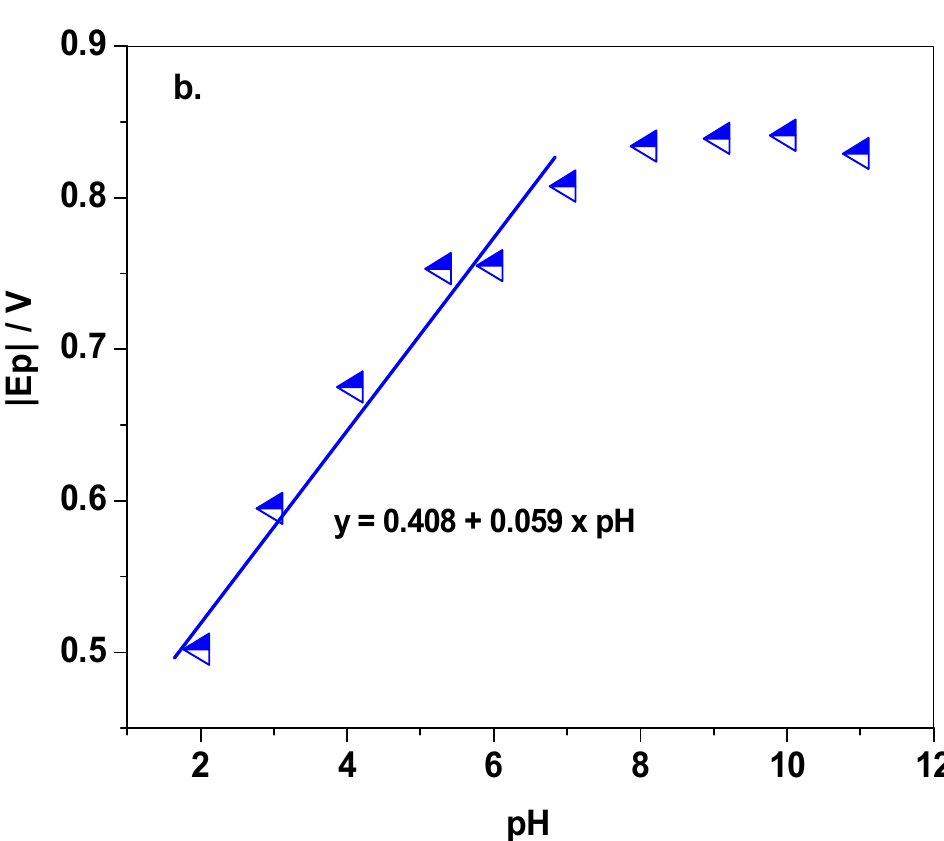
Figure 5. Variation of |I p | ( a ) and |E p | ( b ) with the pH of BR solution (pH 2– pH 12) .